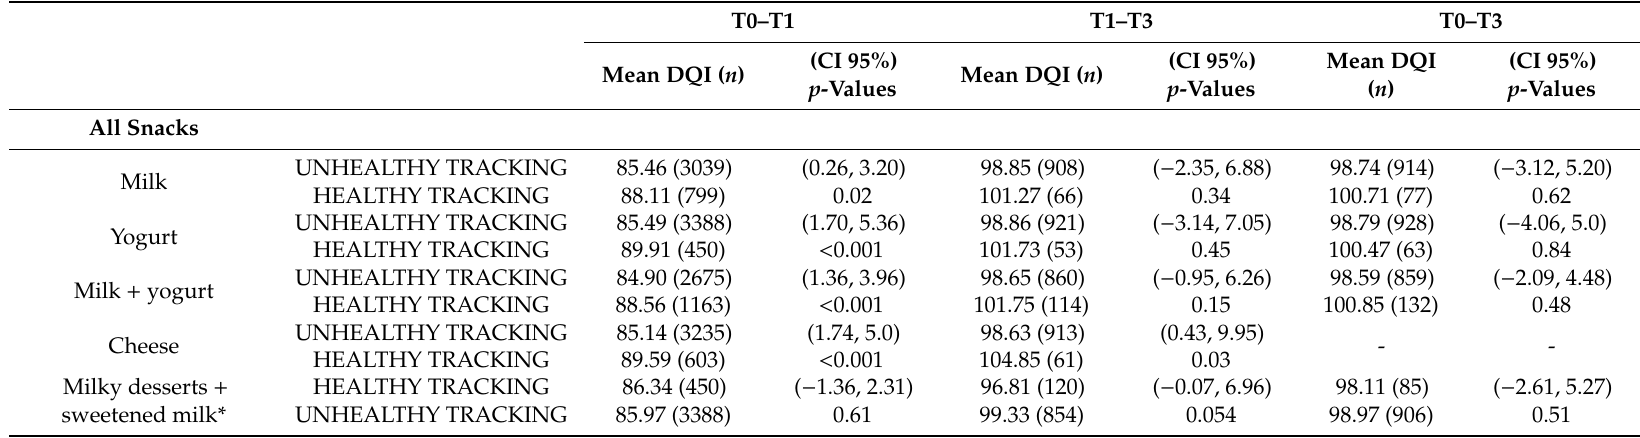
Table 5. Diet Quality Index by groups according to tracking of dairy products consumption at snack meal occasions between T0 and T1, T1 and T3, T0 and